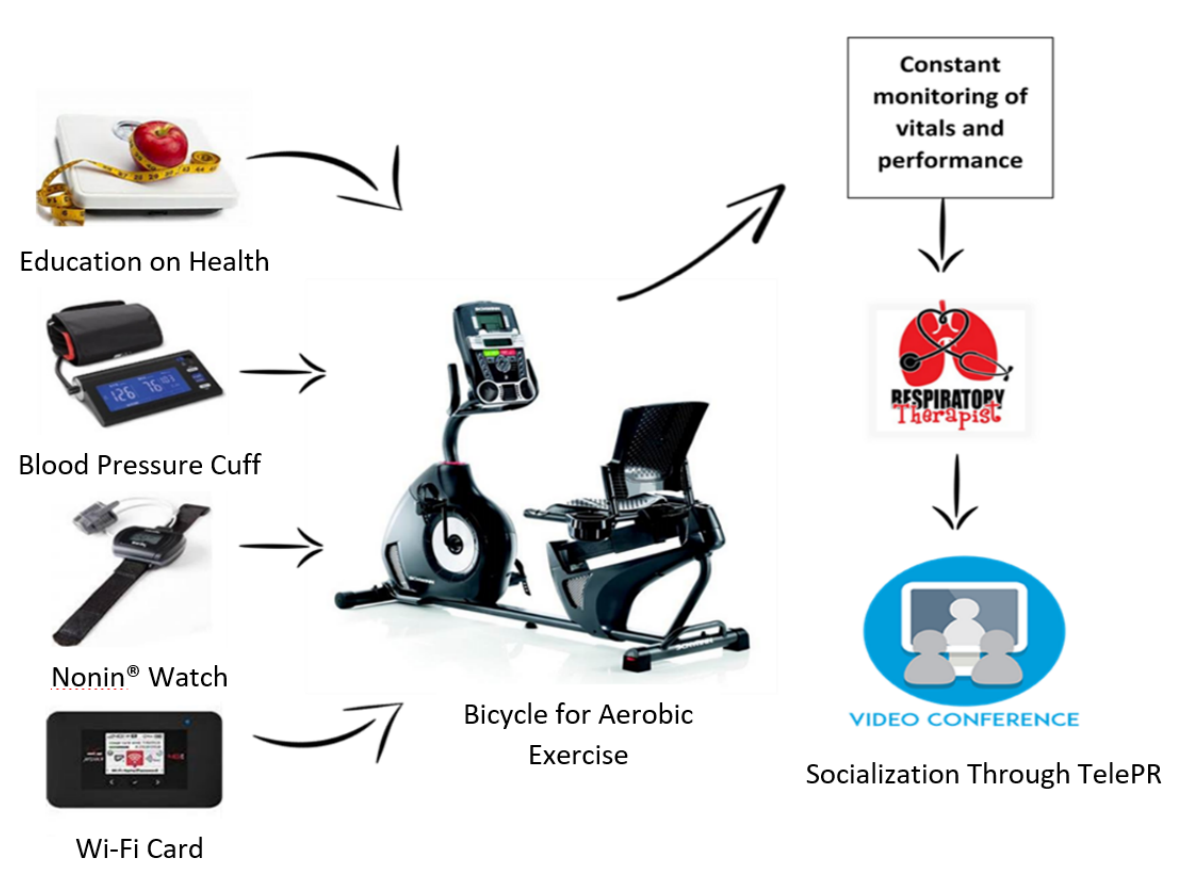
Figure 1. Telehealth-delivered pulmonary rehabilitation (telePR) model of